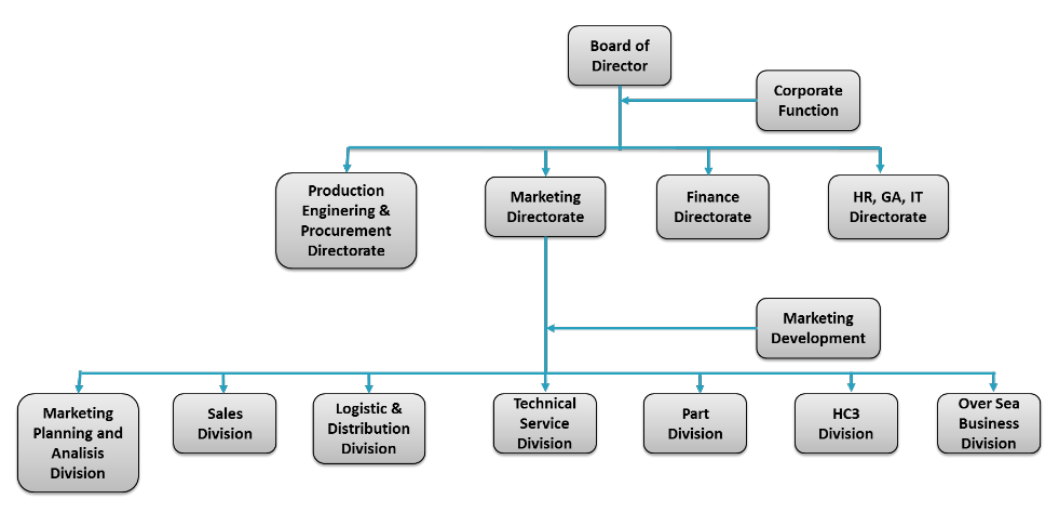
Fig.1 Astra Honda Motor Organization